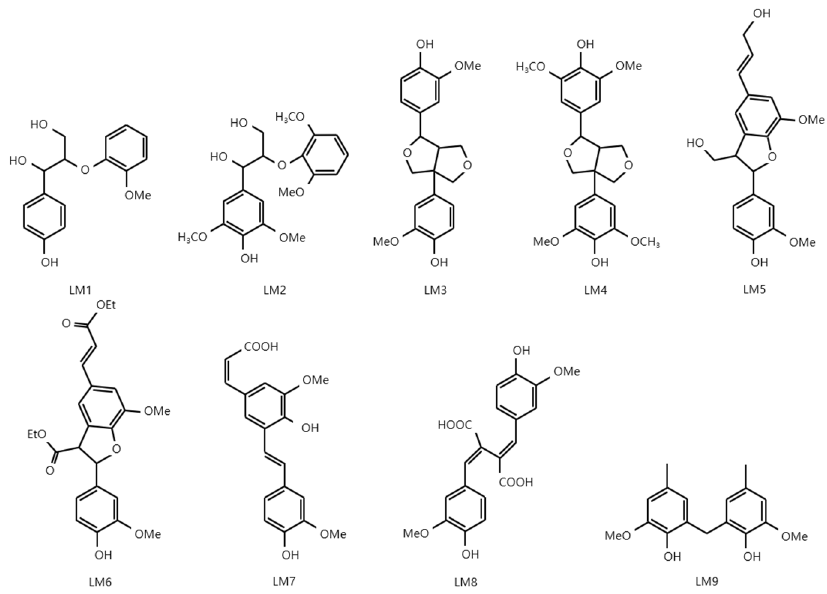
Figure 2. Chemical structures of lignin models. Table 2. Preparation methods and physical properties of lignin